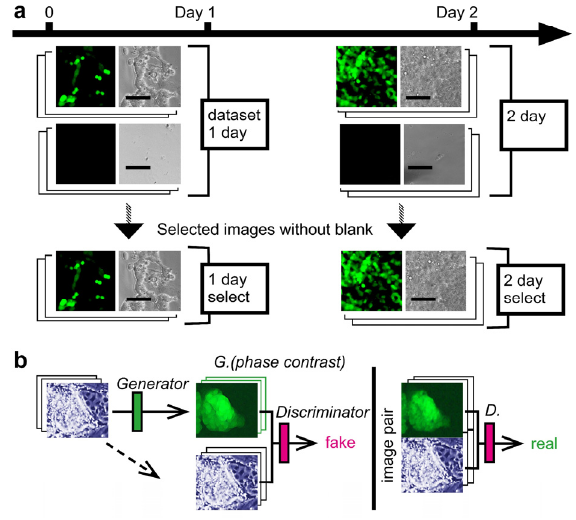
Figure 1. Experimental design. ( a ) Cells image datasets for deep learning. Cell images obtained were from cultured plates on days 1 and 2 to prepare 1000 pairs per dataset. Datasets were used with or without blanks for deep learning. Datasets of 1-day and 2-day included blank image pairs of 158 and 102, respectively. Bars = 100 µ m. ( b ) The CGAN was trained to map grayscale bright-field cell images into color dark-field fluorescence images. Learning was performed for 200 epochs, with a batch size of one per epoch.